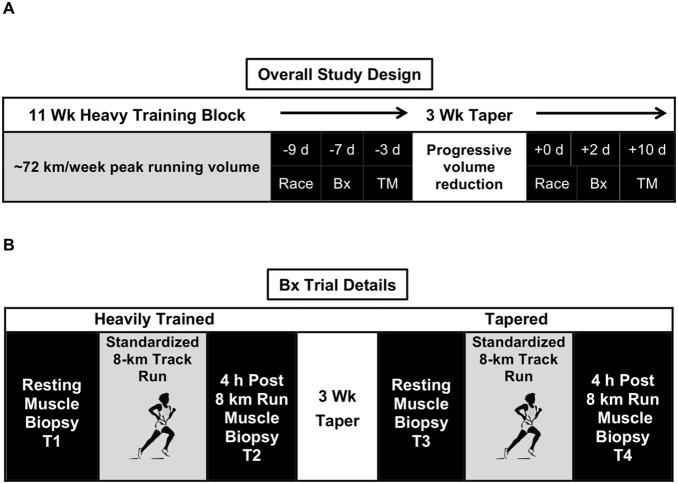
Overall study design (A), and Biopsy trial details (B).Bx = lateral gastrocnemius muscle biopsy, TM = Treadmill VO2max testing.